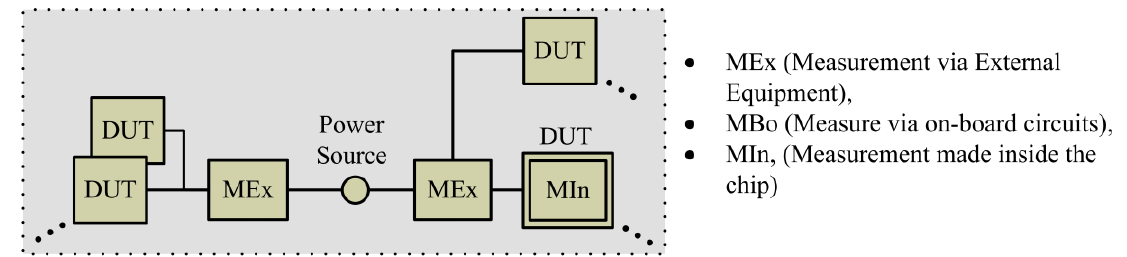
Figure 1. Measurement Systems